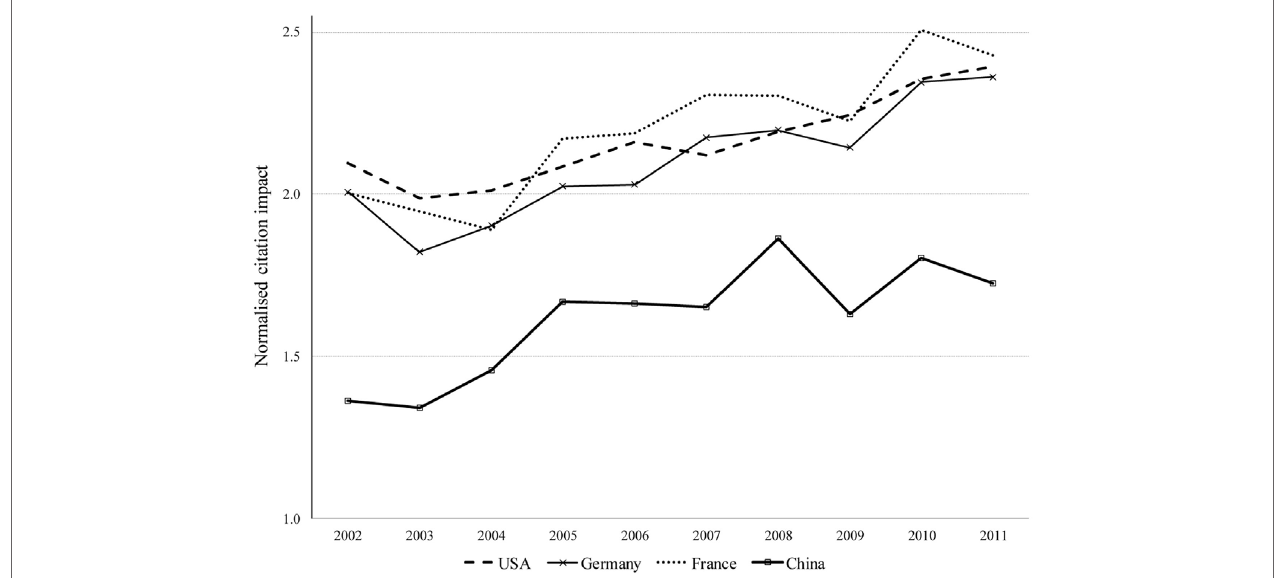
FigUre 4 | Normalized citation impact of UK papers co-authored with one or more partner countries for papers on which a named partner is also a collaborator; other countries may also collaborate; France appears to contribute the greatest